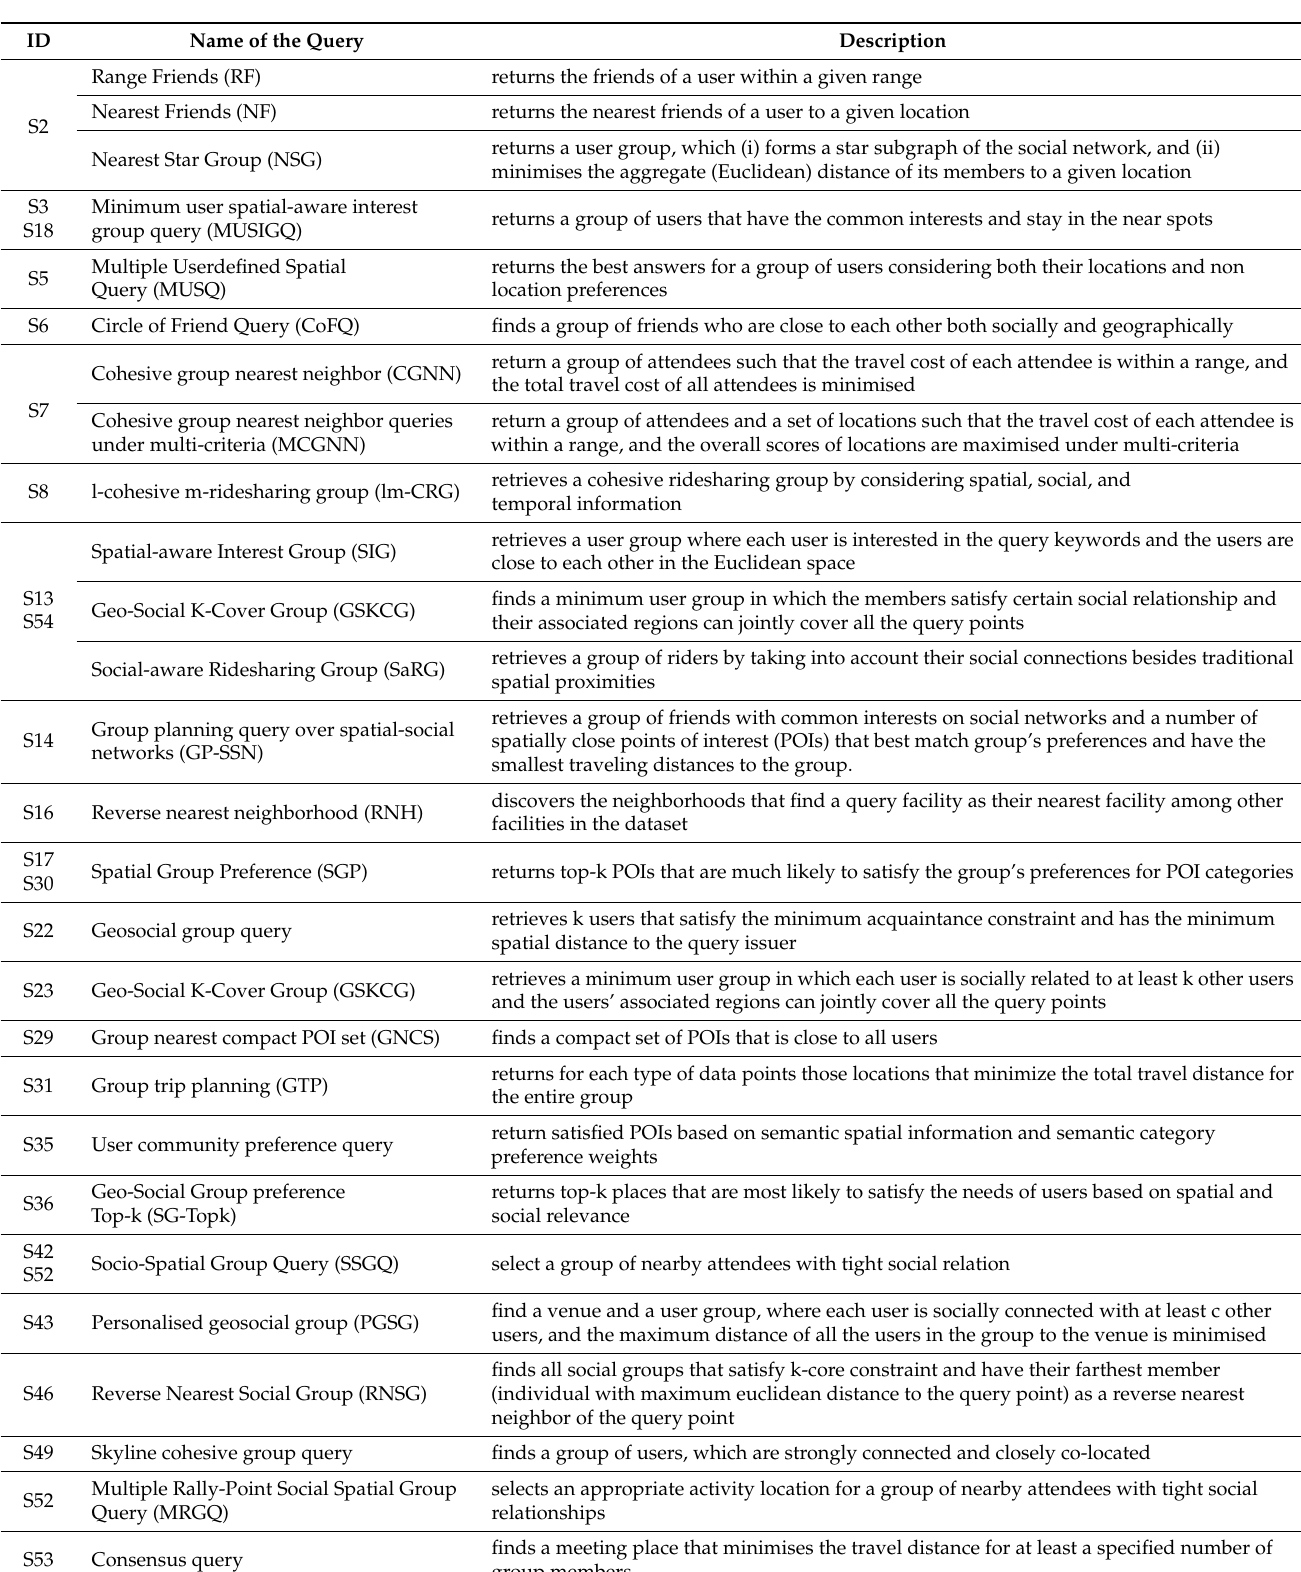
Table 6. Geosocial group